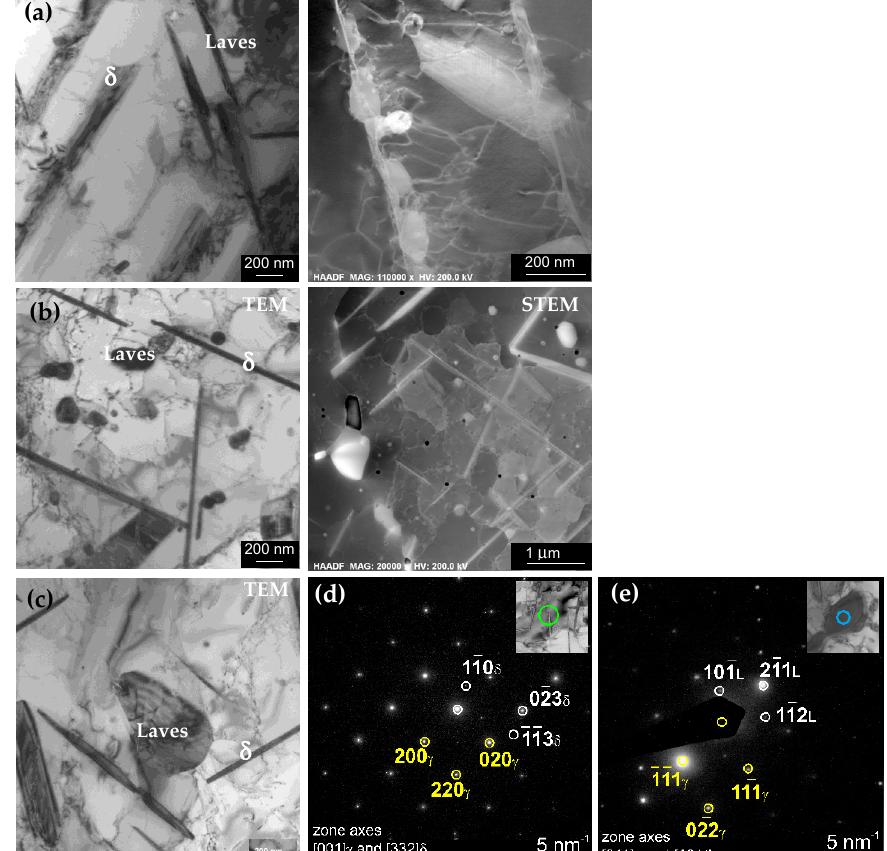
Figure 5. TEM and STEM-HAADF micrographs of the L-PBF Inconel 625 stress-relieved and subsequently annealed at ( a ) 800 °c for 5 h, ( b ) 800 °C for 100 h, and ( c ) 800 °C for 500 h, ( d , e ) SAED patterns of the exemplary δ and Laves phase particles shown in the inserts, together with their solutions; the areas covered by the selective aperture are marked by circles.